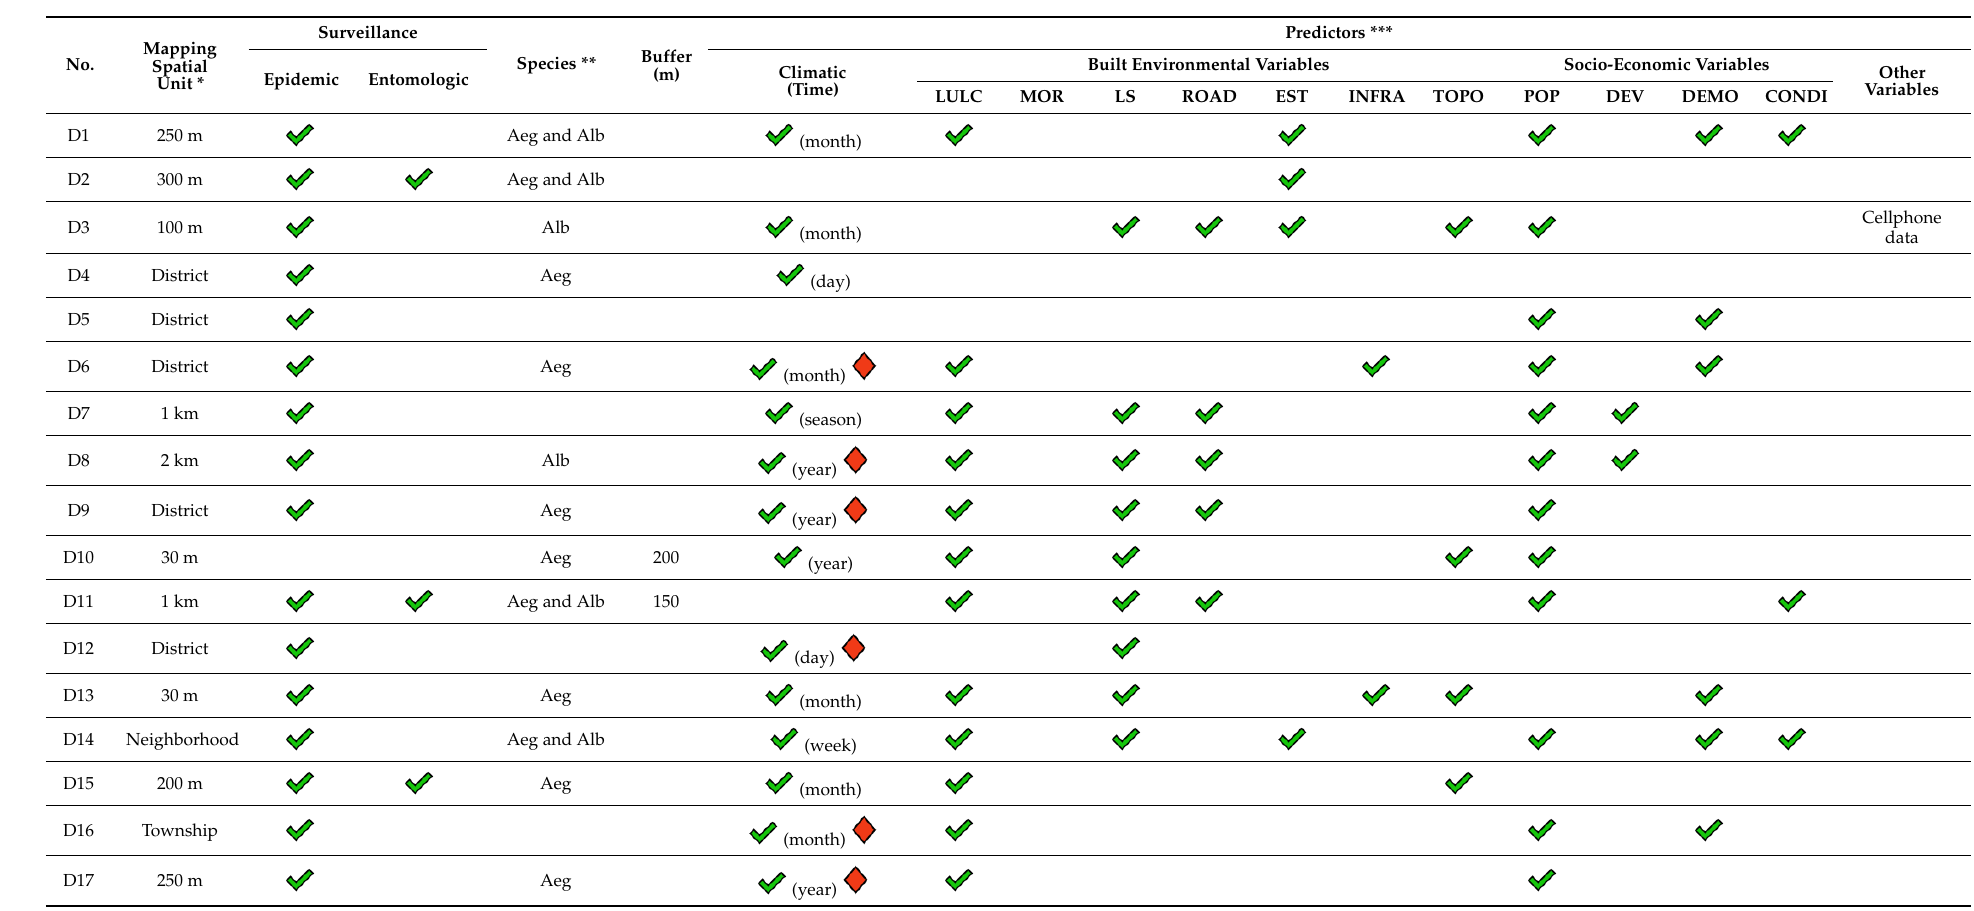
Table A1. The information about data characters in